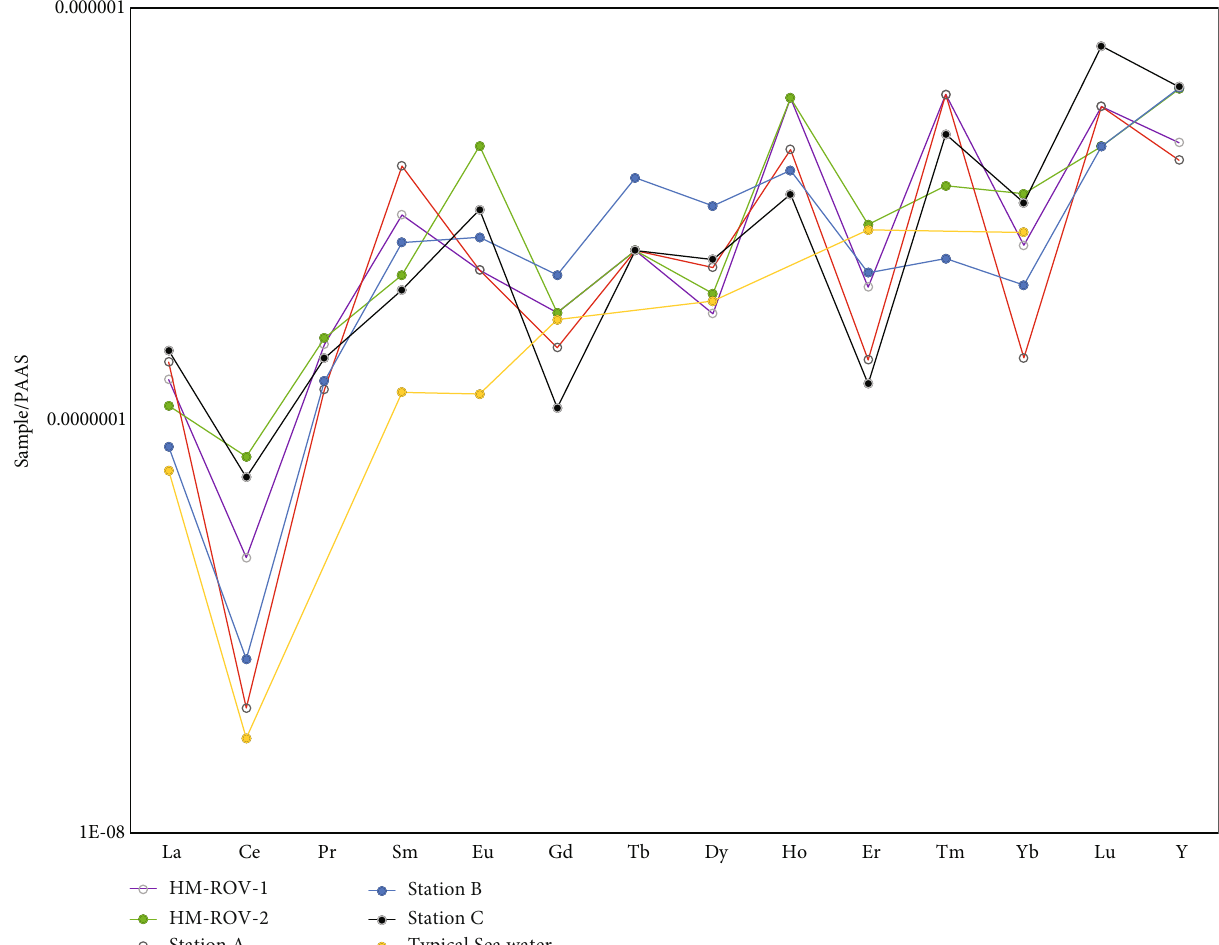
Figure 6: REE distribution curves of water samples at di ff erent stations. The PAAS data are from [45]. The REE distribution curves of water samples at all stations show similar general trends, with heavy REE content higher than that for light REEs. The curves were accompanied by an obvious negative Ce anomaly, showing the typical REE distribution curves of